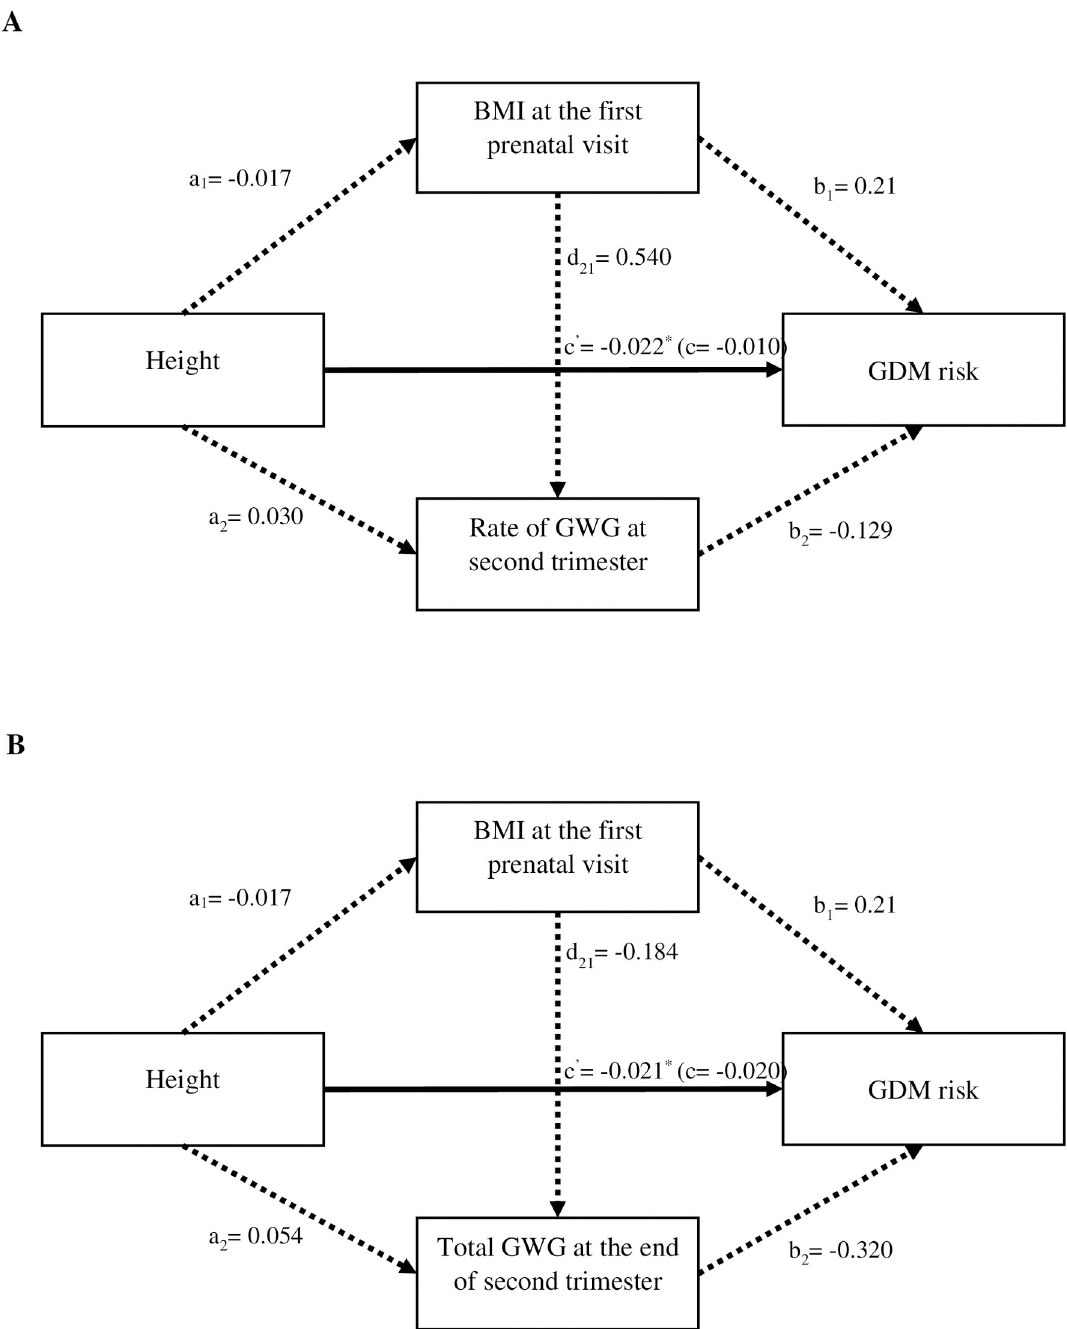
Fig 1. The association between height and GDM risk mediated by BMI at the first prenatal visit and GWG. Bold lines indicate significance of the effect at p < 0.05. Dashed lines indicate that the effects are not significant (p > 0.05). Note. A & B Adjusted for age and gestational week at OGTT